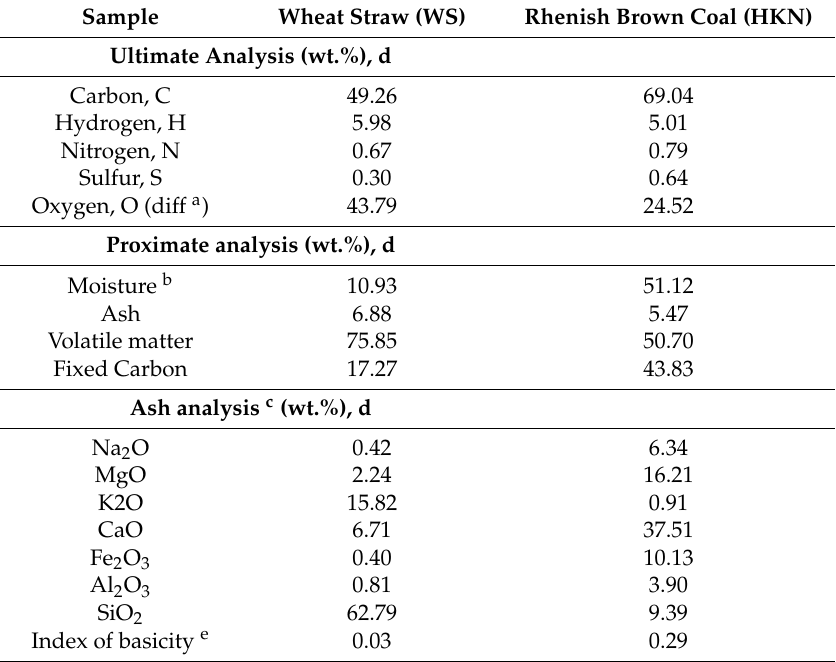
Table 1. Ultimate, proximate and ash analysis of raw brown coal (HKN) and wheat straw (WS). Sample Wheat Straw